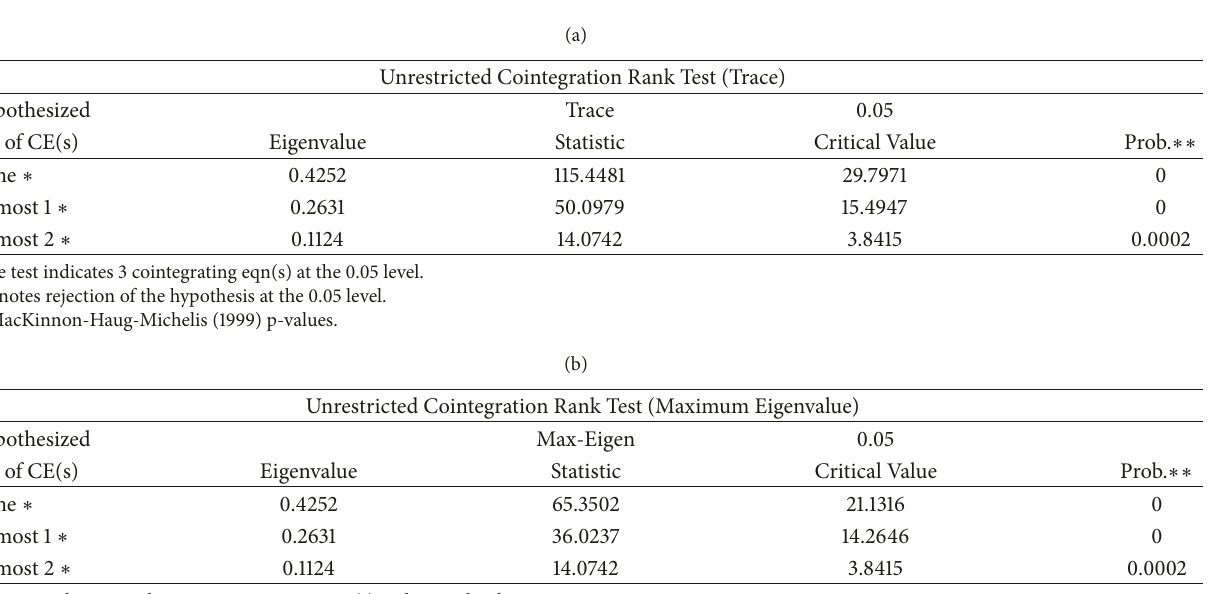
Table 5: Results of cointegration test.